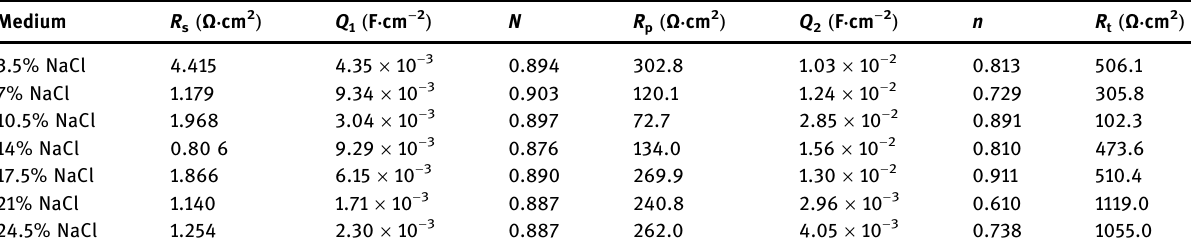
Table 1: Fitting parameters of EIS for samples in NaCl solution with di ff erent concentrations